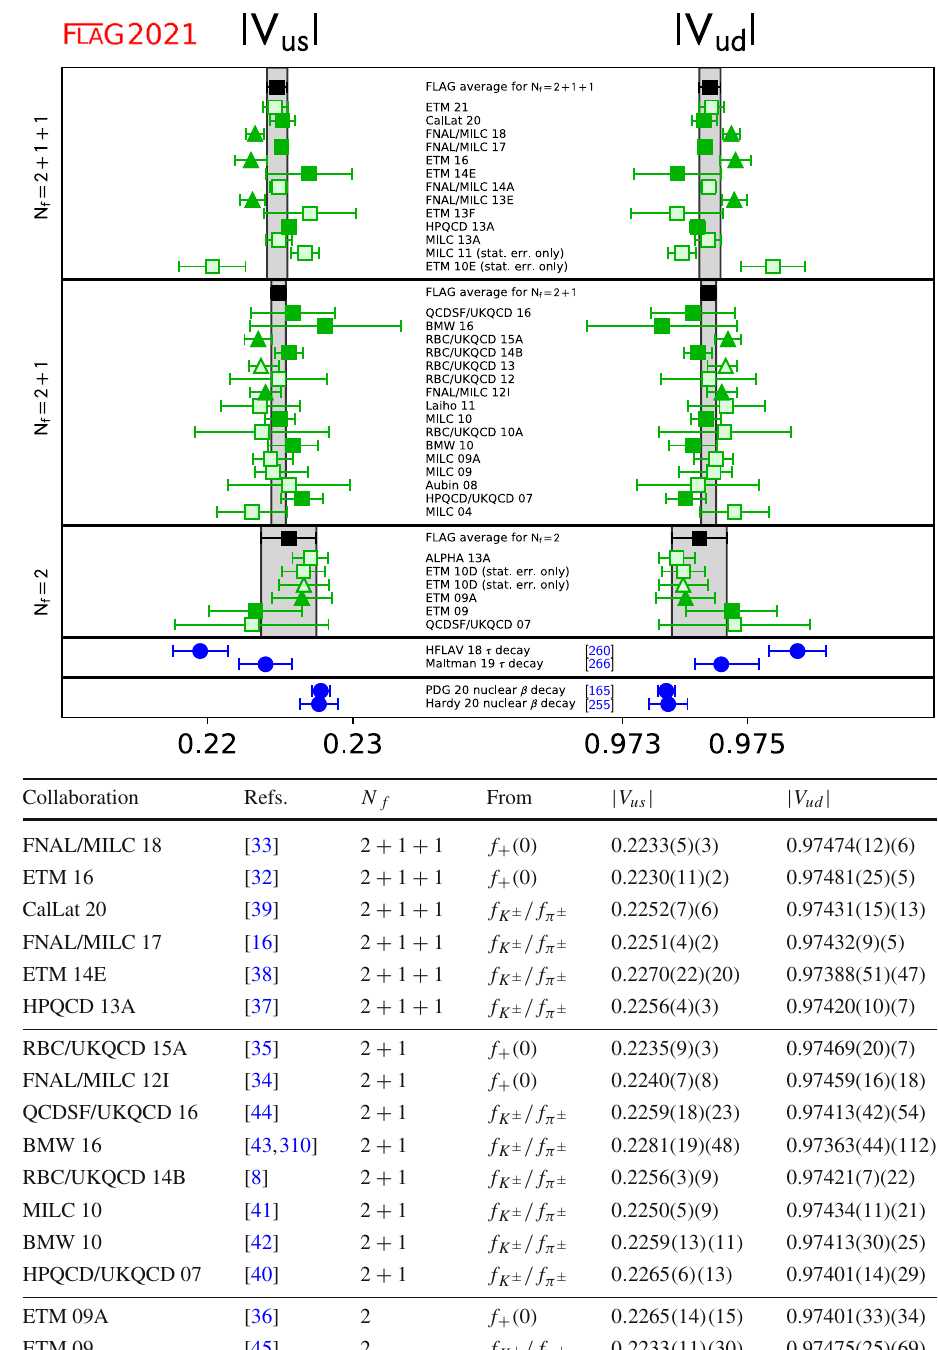
Table 18 Values of | V us | and | V | obtained from the lattice ud determinations of either f + ( 0 ) or f K ± / f π ± assuming CKM unitarity. The first number in brackets represents the statistical error including the experimental uncertainty, whereas the second is the systematic one